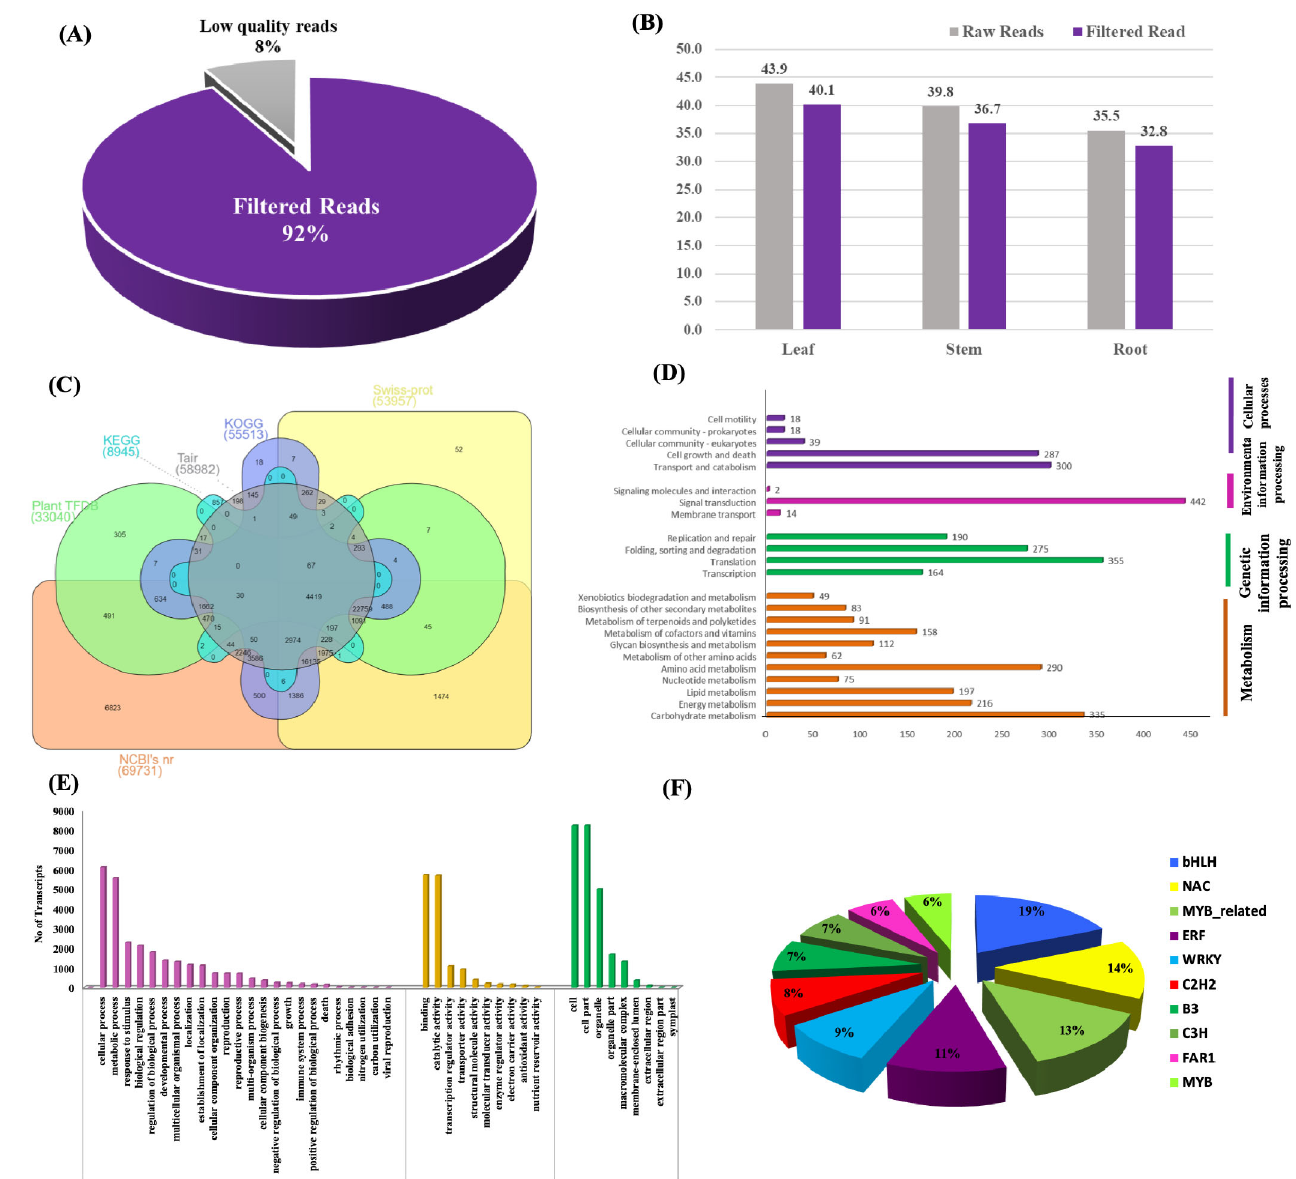
Figure 1. ( A ) Quality filtering of sequenced reads. ( B ) High-quality filtered reads in leaf, stem, and root tissues. ( C ) Venn diagram representing the functional annotations of transcripts with six public databases. ( D ) KEGG annotation grouped transcripts into four main categories: metabolism, genetic-information processing, environmental-information processing, and cellular processes. ( E ) Histogram representing gene ontology (GO) grouped into three functional categories: biological processes, molecular functions, and cellular components. ( F ) Pie chart representing classification of major transcription-factor families. Table 1. Total raw and filtered reads generated for leaf, stem, and root tissues of A. glauca.